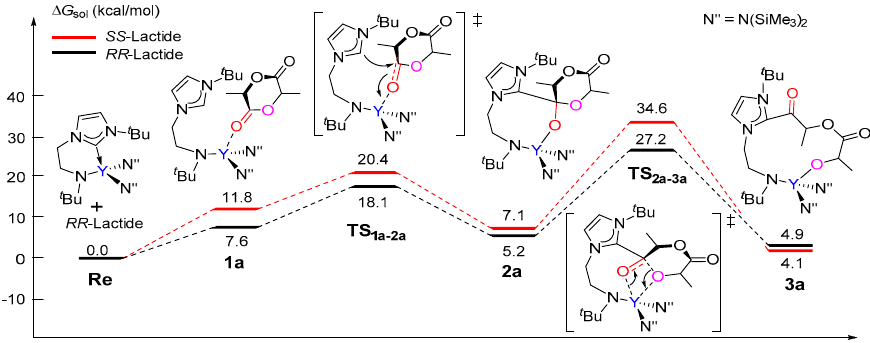
insertion along with path B. The resulting tetrahedral intermediate 1b rearranges to give intermediate 2b . Then, 2b overcomes the transition state TS 2b-3b to accomplish the ring-opening of the lactide moiety, accompanied with the concerted cleavage of the acyl–oxygen bond and the formation of the new metal-alkoxyl bond. After the ring-opening, the chain reorganization occurs, affording a more stable five-membered metallacyclic product 4b . The calculated energy barriers for the ring-opening step are less than that of the insertion step. As a whole, the conversion of the reactant into a product is exergonic by 14.1 and 12.3 kcal/mol for ( S , S )-lactide and ( R , R )-lactide, respectively (Figure 2). A comparison of the energy profiles for paths A and B (Figures 1 and 2) indicates that path B is more kinetically favorable than path A (an energy barrier of 34.6 kcal/mol and 27.2 kcal/mol vs. 26.4 kcal/mol and 25.1 kcal/mol), in addition to being more thermodynamically favorable (4.9 kcal/mol and 4.1 kcal/mol vs. − 12.3 kcal/mol and − 14.1 kcal/mol). It is also obvious that the reaction of ( R , R )- lactide is more kinetically favorable than that of ( S , S )-lactide (Figures 1 and 2). These results suggest that the NHC moiety could not directly participate in the insertion and ring-opening processes and the ( R , R )-lactide could be favorably involved at the chain initiation step. Figure 2. Calculated free energy profile for the chain initiation of the ROP of rac -lactide along path B. TS Re-1b , nucleophilic addition transition state; TS 2b-3b , ring-opening transition state. The reasonable chain initiation pathway was studied, as shown above. However, the role of NHC is unclear in the process of the ROP of rac -lactide. In order to further investigate the role of NHC in the chain initiation step, we modelled the de-coordination of the NHC moiety from the metal